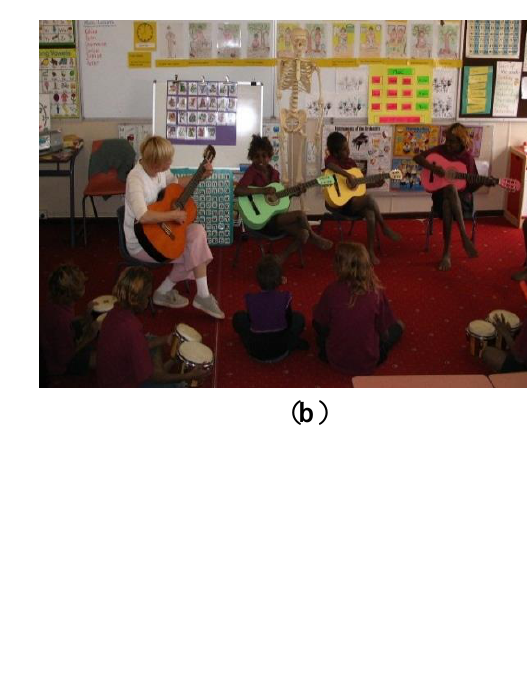
Figure 3. ( a ) Science: Learning about the skeletal system; ( b ) Music: Singing a skeleton song; ( c ) Science and Math’s: Making a plaster cast; ( d ) Art: Painting torsos; ( e ) Art: Painting a skeleton; ( f ) Health: Learning about healthy food